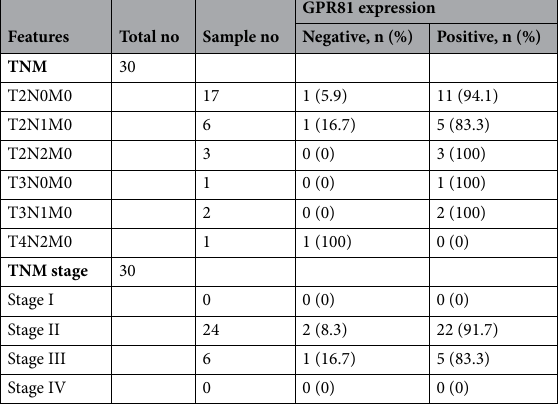
Table 1. Associations between GPR81 expression and clinicopathological characteristics of human breast cancer specimens (n = 145). GPR81 G-protein-coupled receptor 81, TNM